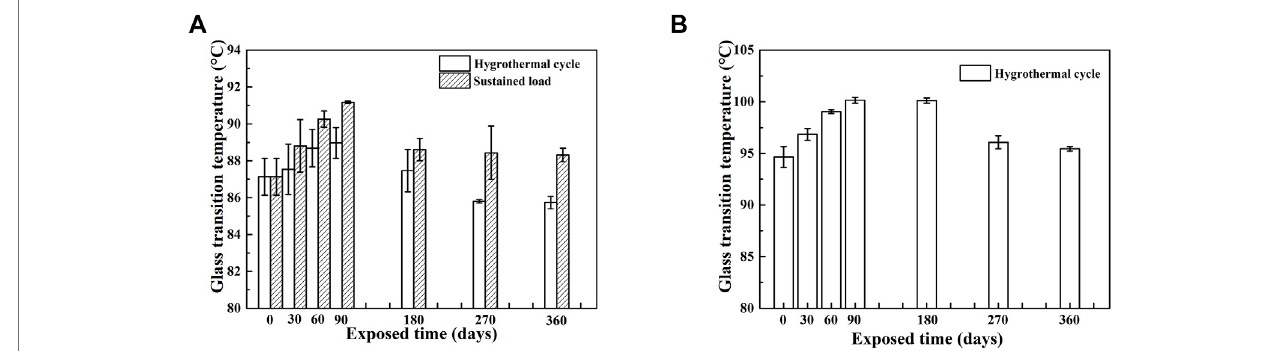
FIGURE 4 | Glass-transition temperature of (A) UP pro fi les and (B) VE pro fi es under the hygrothermal cycle and sustained load.